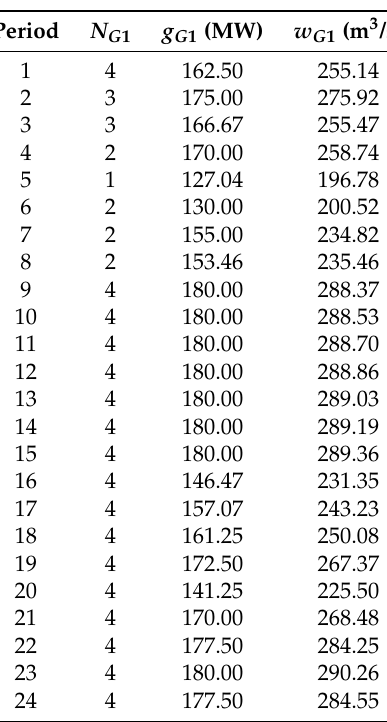
Table 5. Results with power losses-based objective function-scenario